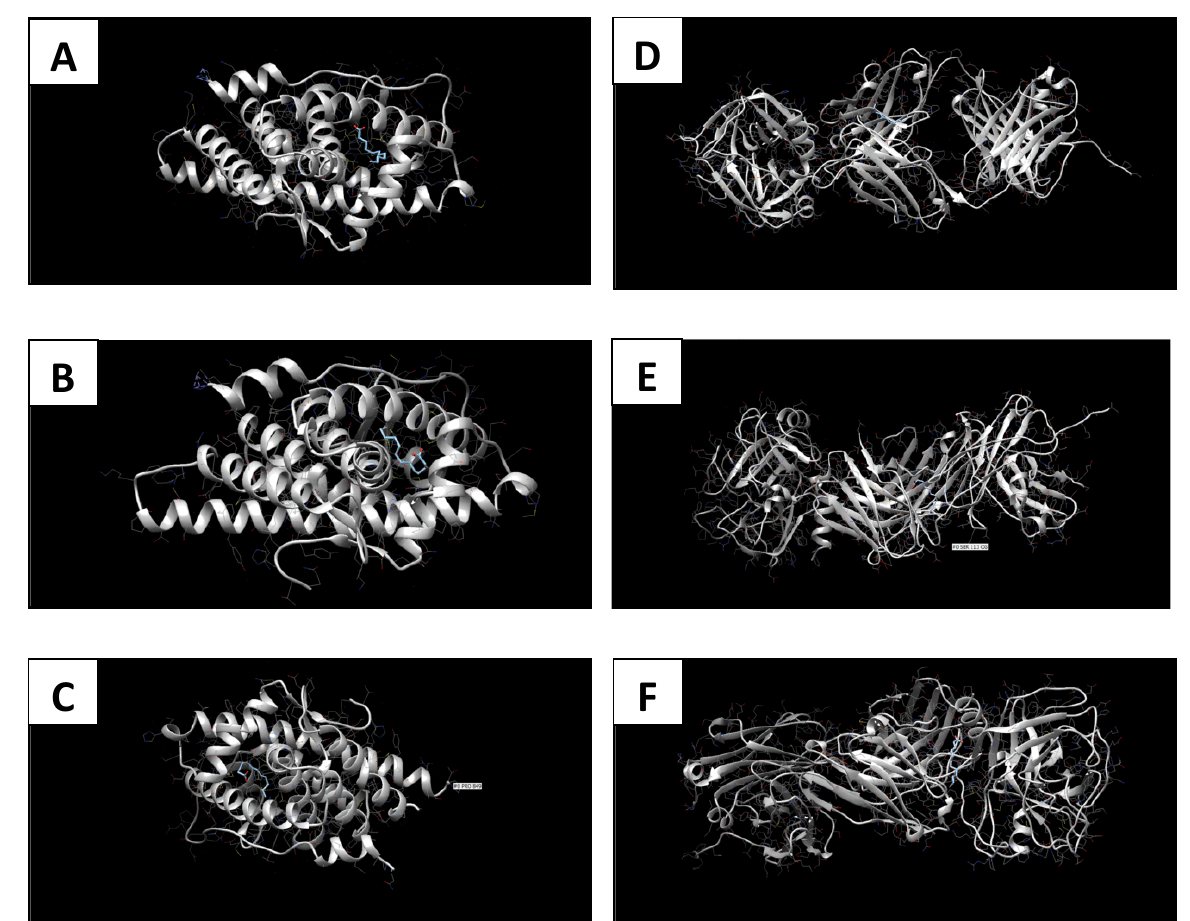
Figure 3. Molecular docking of lauric acid with androgen receptor (AR) PDB codes: 3RLJ (A), 5T8J (B), 5VO4 (C), and protein specific antigen (PSA) PDB codes: 2ZCH (D), 2ZCK (E), 2ZCL